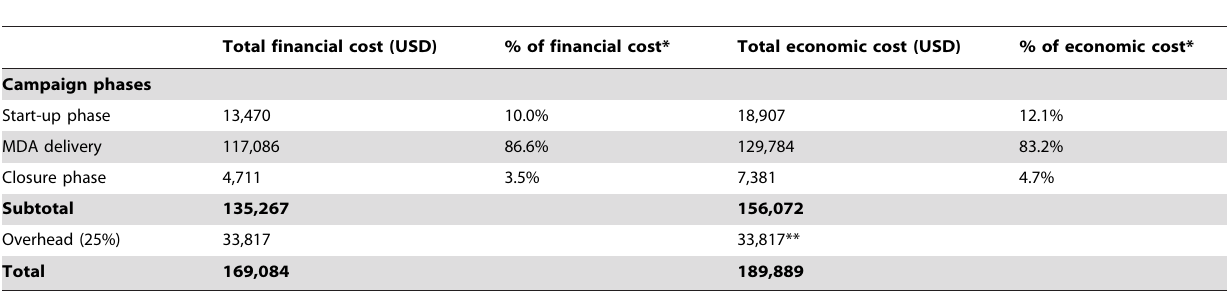
Table 2. Financial and economic costs, and associated cost profiles, for the three phases of antibiotic